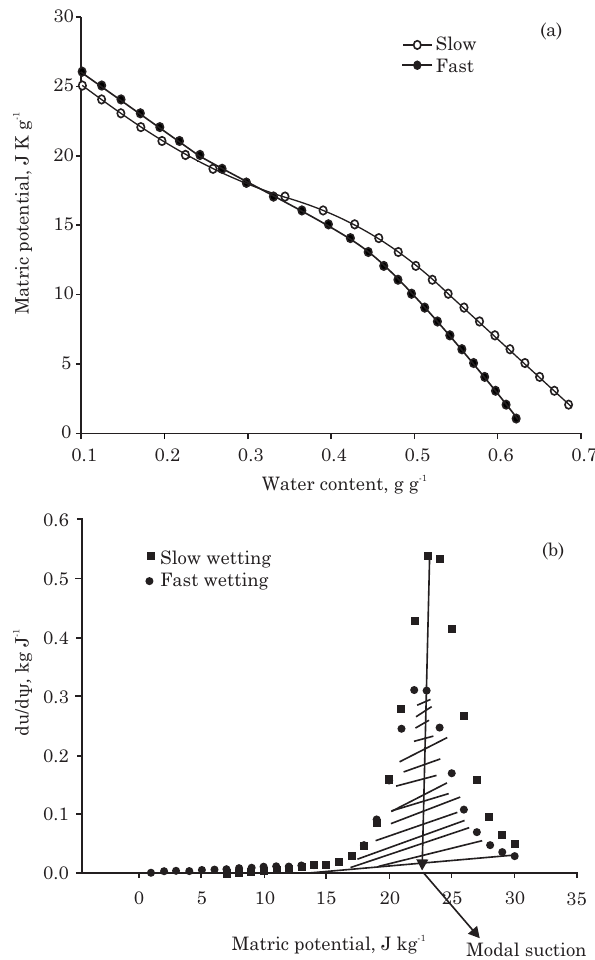
Figure 2. Schematic representation of the water drain curve (a) and the moisture characteristic curve for fast and slow wetting